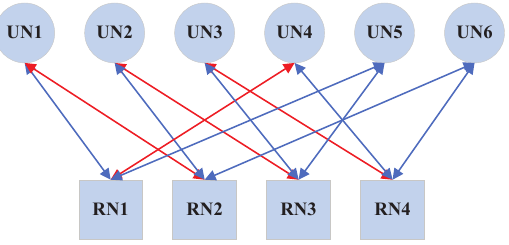
Figure 2. The factor graph with parameters J = 6, K = 4, N = 2, and df =